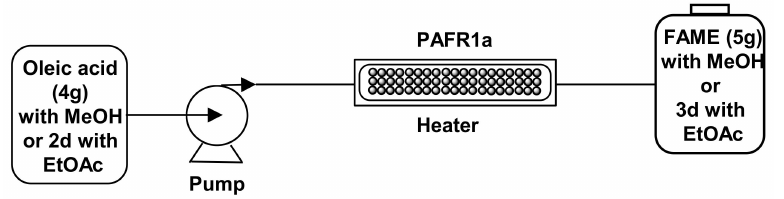
Figure 5. Packed-bed tubular reactor.